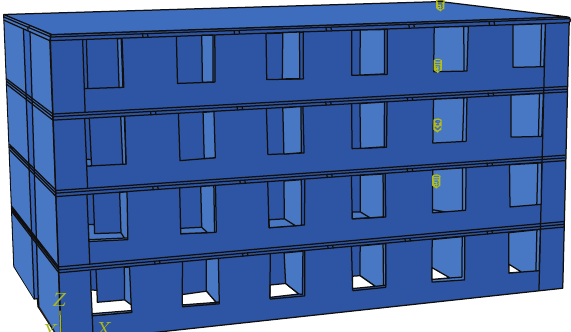
Figure 4: Model 2 without structural columns